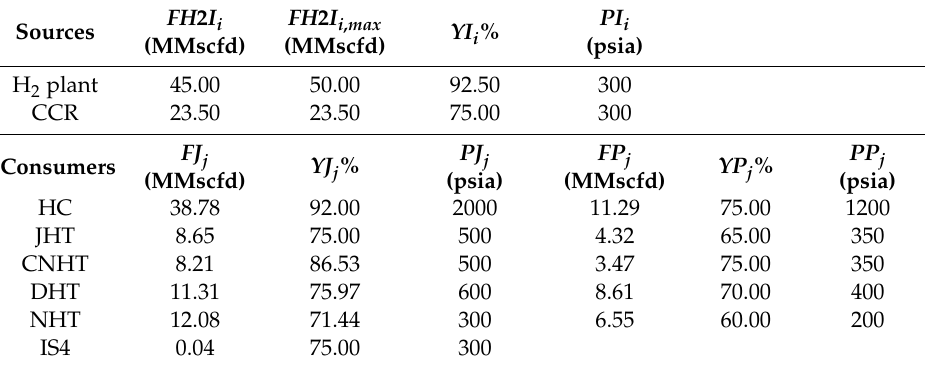
Table 3. Flowrate, purity, and pressure information used in Example